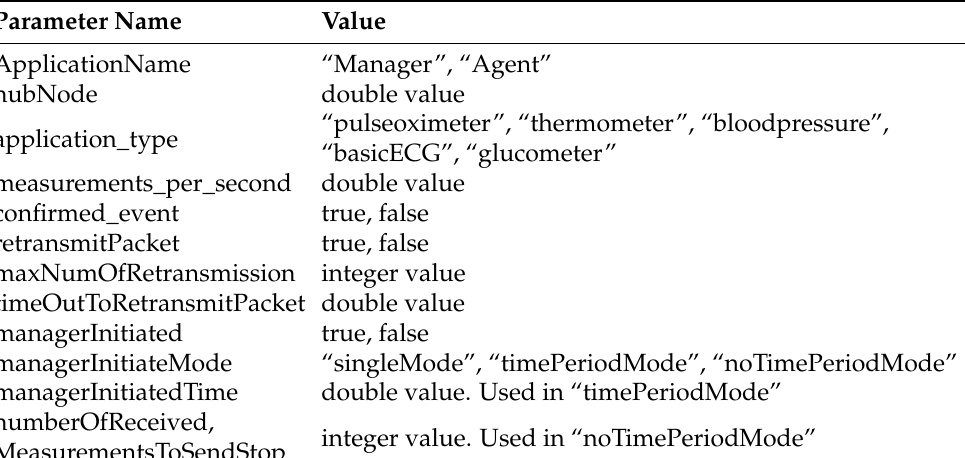
Table 2. BNS Healthcare Application Layer Configurable Simulation